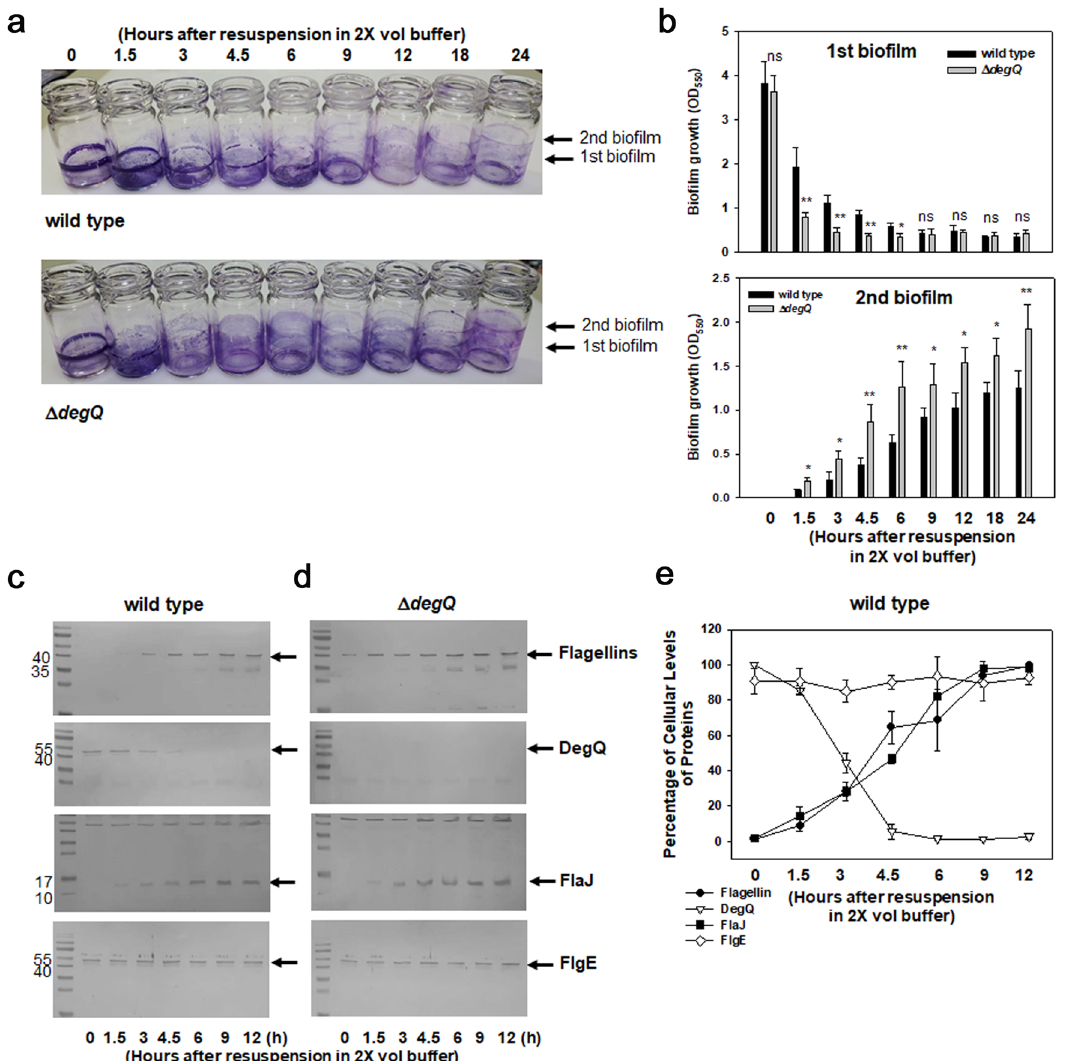
Fig. 4 Effect of degQ mutation on the cellular levels of fl agellins during dispersal from bio fi lms. a , b Dispersal of bacterial cells from bio fi lms. Bio fi lms formed by the wild-type (upper image) and Δ degQ (lower image) in 2 ml AB-fumarate broth for 48 h were further incubated in 4 ml PBS, to allow the second bio fi lms to be formed around the air – liquid interfaces by the cells dispersed from the fi rst bio fi lms, as previously described 60 . At various time points during 24 h incubation (0, 1.5, 3, 4.5, 6, 9, 12, 18, and 24 h), the remaining fi rst bio fi lm and newly formed second bio fi lm were stained with crystal violet, and the dyes associated with each bio fi lm were estimated by spectrophotometry at 550 nm ( b ). The error bars on the bar charts represent standard deviation. The P- values for the comparison with wild type are indicated (Student ’ s t -test; ns, not signi fi cant; *0.005 < P < 0.05; ** P < 0.005). c – e Cellular levels of various proteins during the dispersal period. Crude extracts of cells in the fi rst bio fi lms, which remained in the original positions for the initial 12 h period of the dispersal stage, were subjected to western blotting analyses to monitor the cellular levels of fl agellins, DegQ, FlaJ, and FlgE in the wild type ( c ) and Δ degQ ( d ). The intensities of resultant protein bands in the wild-type blots were estimated by densitometric reading, and the relative levels of each protein were plotted against incubation time points ( e ). The error bars represent standard